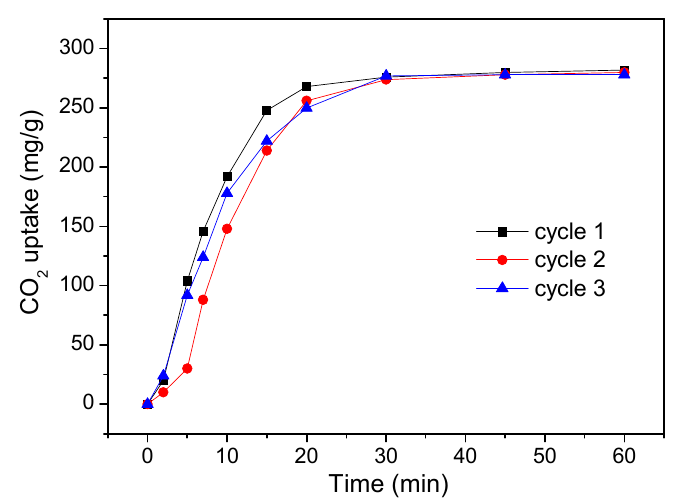
Figure 7. Recycling performance of HSCP-70 after regeneration at 250 °C.